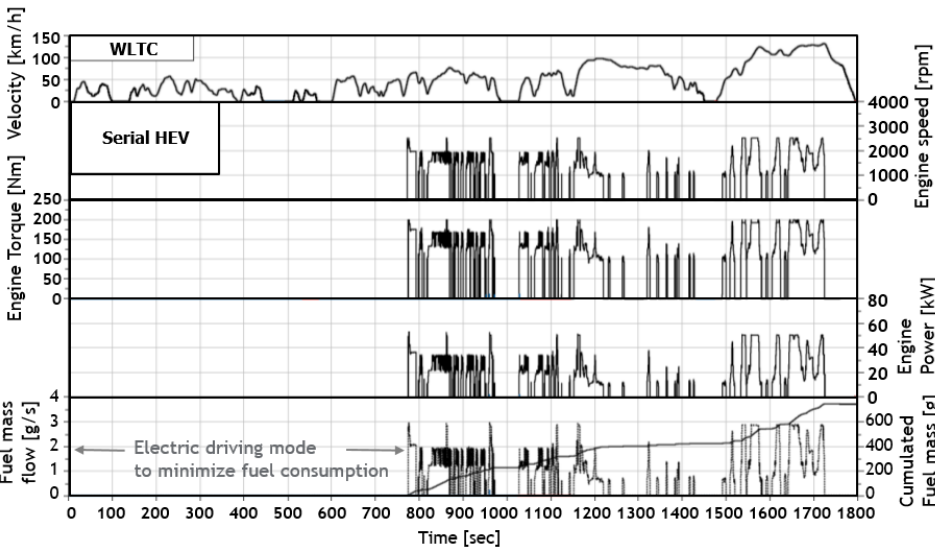
Figure 10. Speed, torque, power, and fuel consumption of CN15 engine with serial hybrid configuration (WLTC).